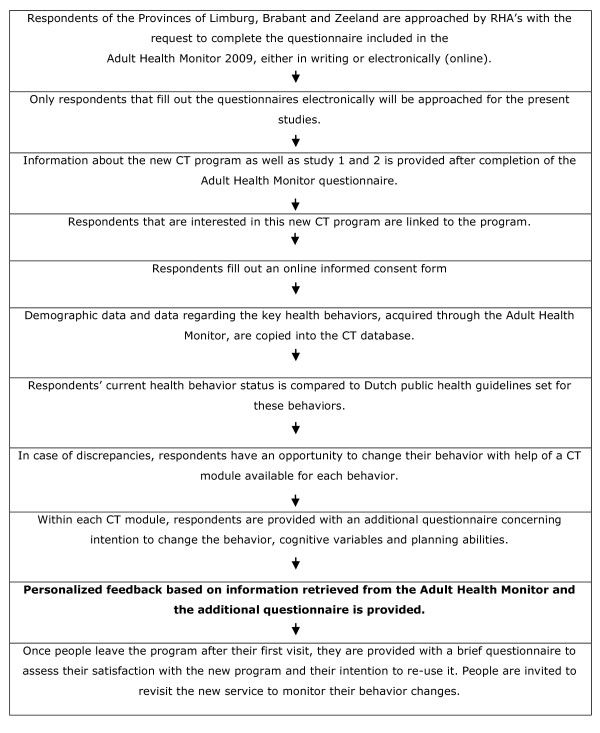
Flowchart study 1.